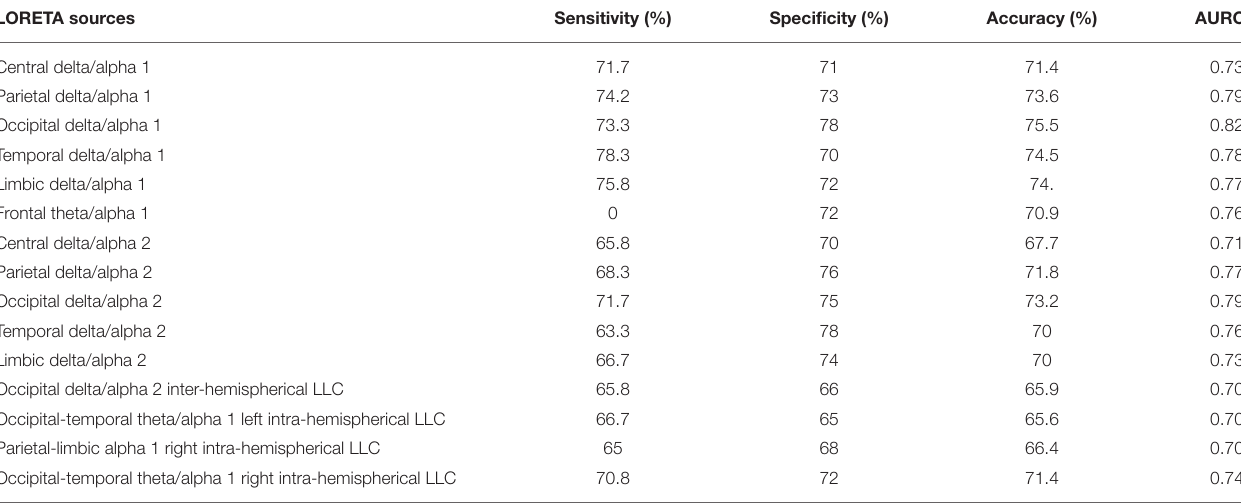
TABLE 7 | Results of the classification between single AD and Nold subjects based on EEG markers of source activity and lagged linear connectivity. LORETA